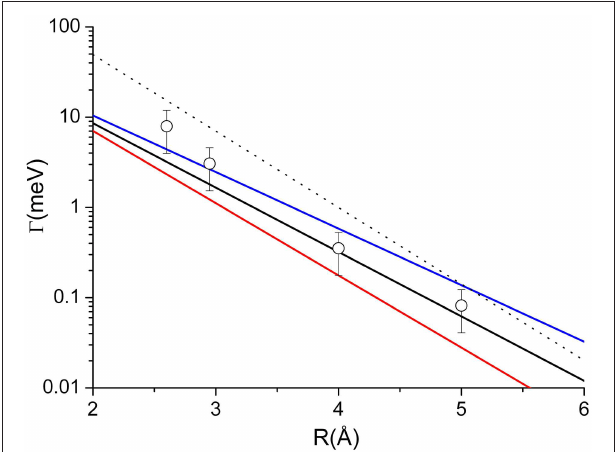
FIGURE 4 | Comparison of the radial dependence of the average Γ value obtained for two prototype systems: Dashed line —the Ne*-H 2 O case, discussed in the text and giving the ground electronic state of water ion; Full lines—the Ne*-Kr case, obtained by Gregor and Siska (1981) where black, red, and blue colors represent average value, lower and upper limits, respectively. For the same system the circles are the results of the present investigation.